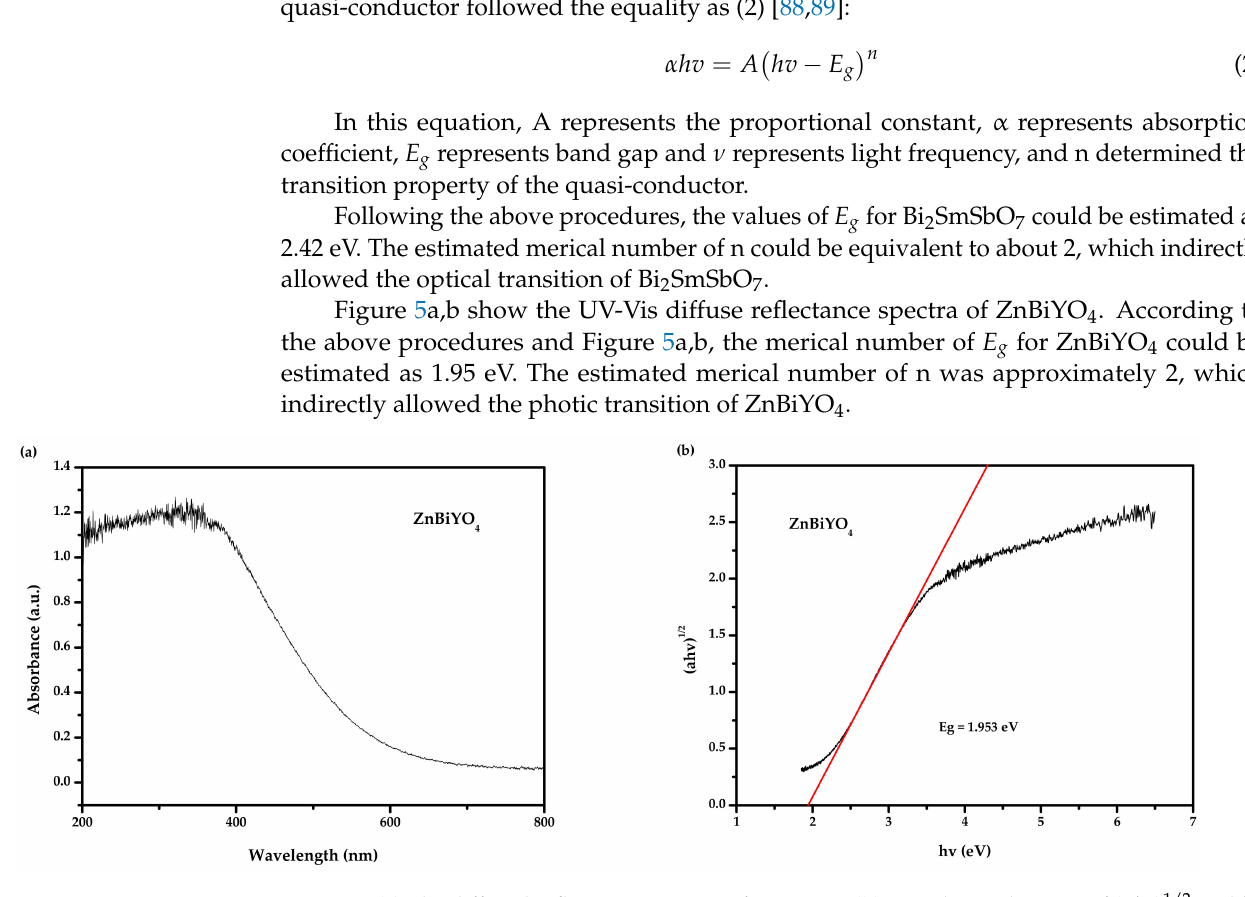
Figure 5. ( a ) The diffused reflection spectrum of ZnBiYO 4 ; ( b ) Correlative diagram of ( α h ν ) 1/2 and h ν for ZnBiYO 4 .